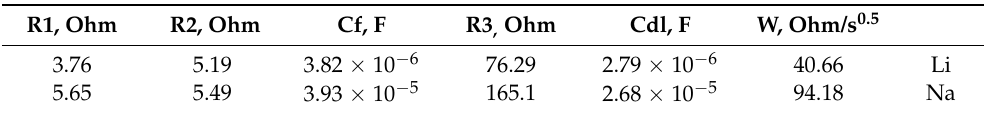
Table 1. Equivalent circuit parameters, calculated from the impedance spectra during the insertion of lithium and